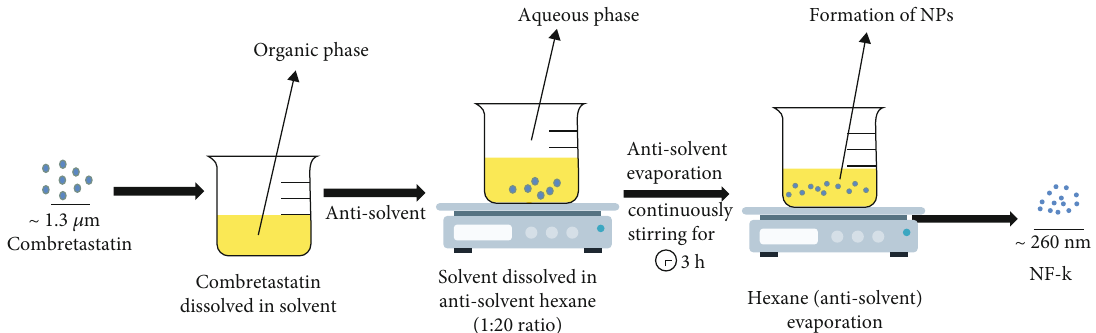
Figure 2: Schematic representation of synthesis of